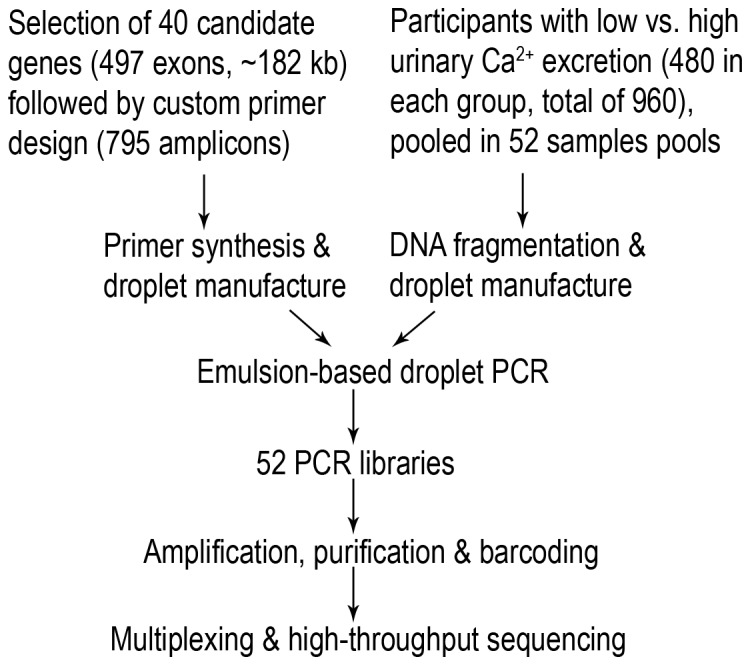
Simplified schematic illustration of the study design utilizing emulsion-based droplet PCR technology and next-generation sequencing.